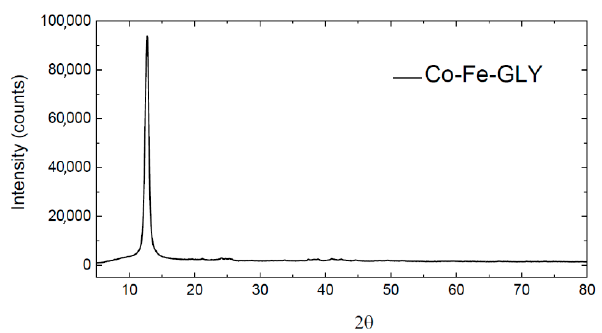
Figure 1. Diffractogram of Co-Fe-GLY.